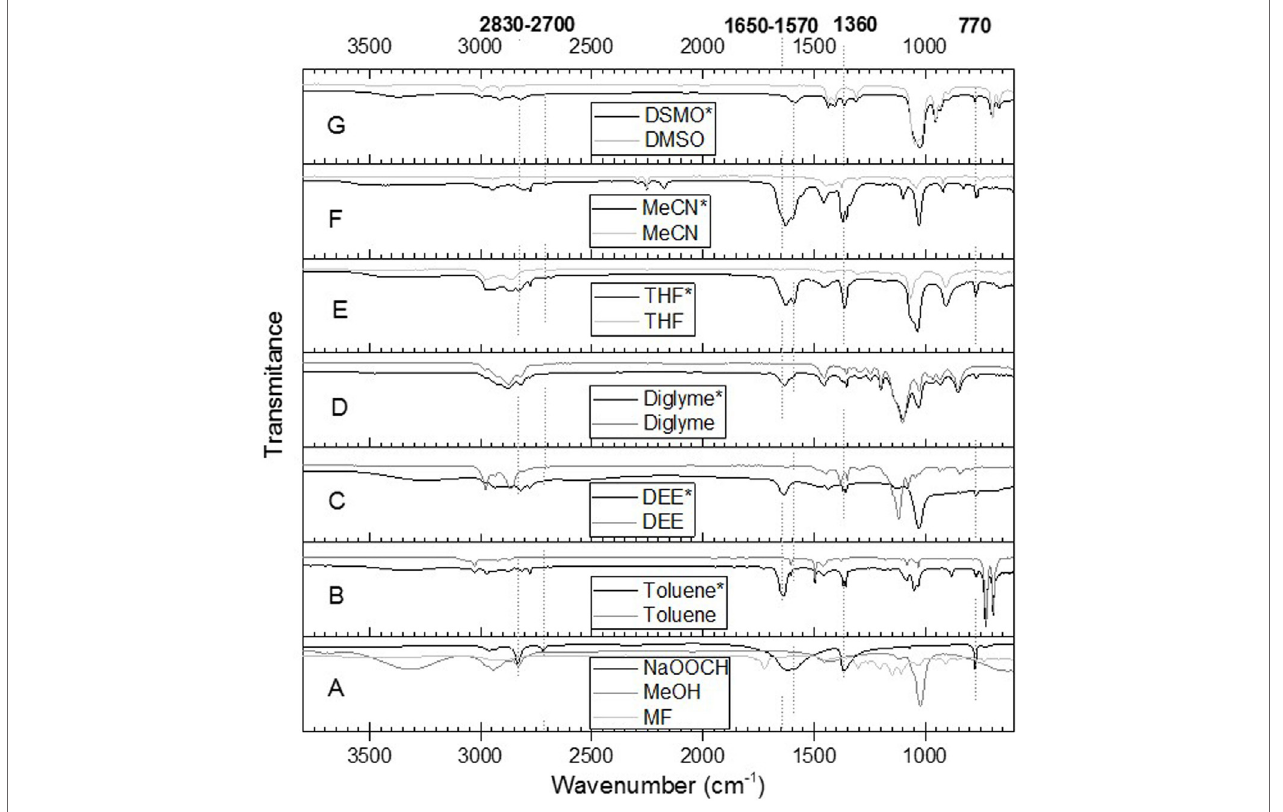
FigUre 11 | ATR-IR spectra of solvent (B–G in gray), and reaction mixture (B–G, black with *). The spectra A is for MeOH, methyl formate, and NaOOCH. The NaOOCH (in black) was adopted from NIST data base (Stein,